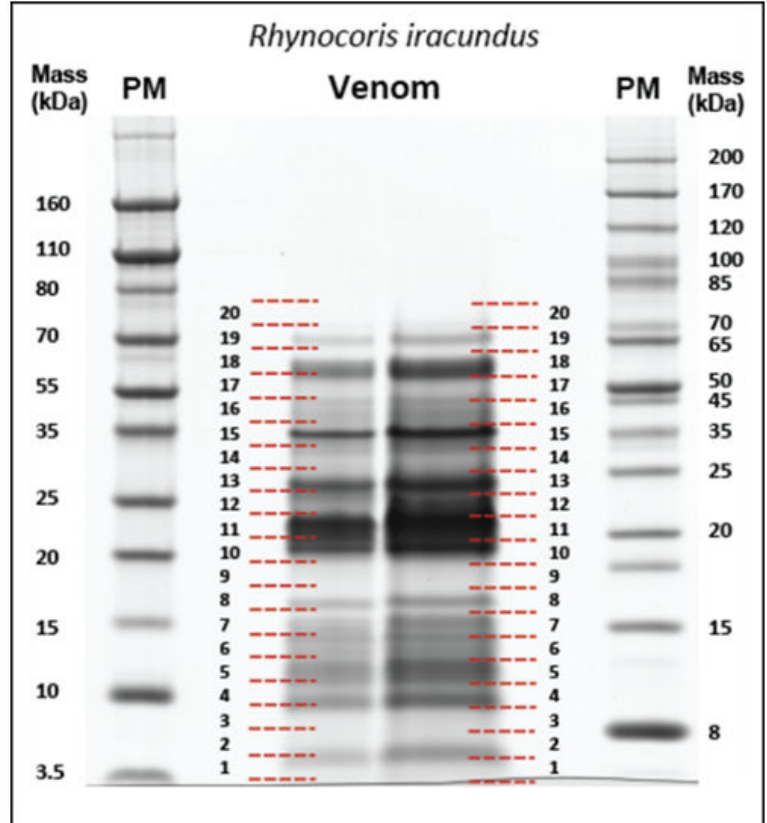
Figure 7. SDS-PAGE analysis of Rhynocoris iracundus venom proteins. Proteins collected from the venom glands of R. iracundus were separated by SDS-PAGE and stained with Coomassie Brilliant Blue R250. Numbers on the left and right of the lanes with venom indicate the 20 bands cut out from the gel and processed as individual samples for LC-MS/MS. PM = protein